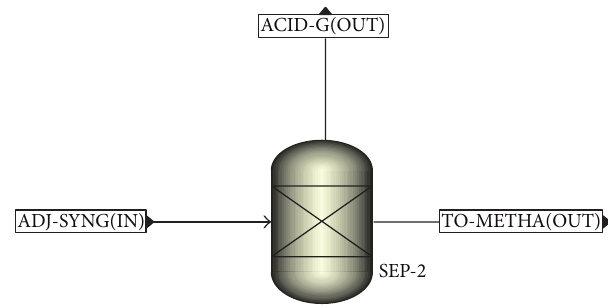
Figure 8: Aspen Plus AGR hierarchy diagram to simulate the acid gases clean-up in the coal-SNG process.